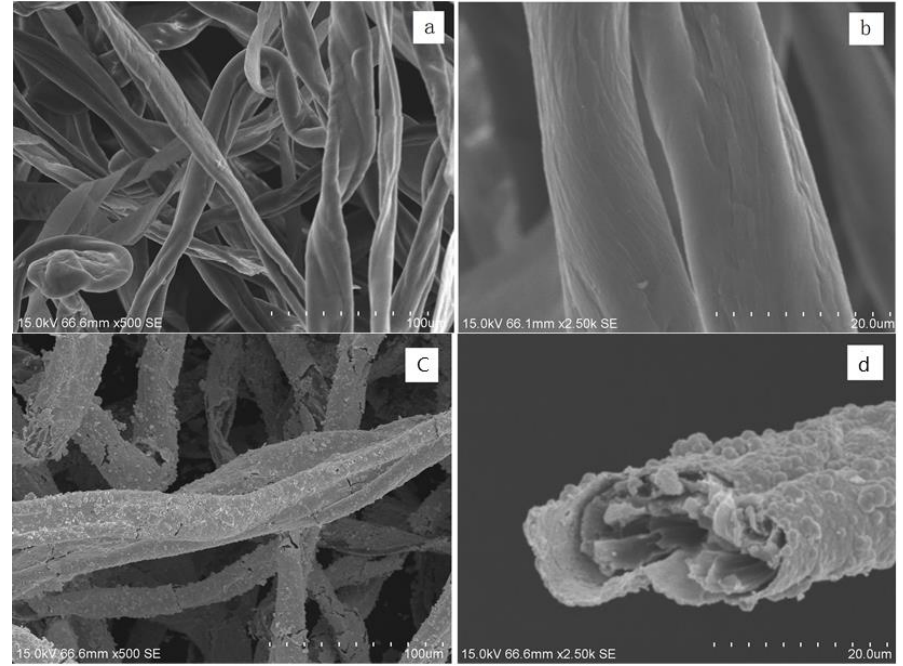
Figure 2. SEM images of ( a , b ) pristine cotton and ( c , d ) modified cotton.